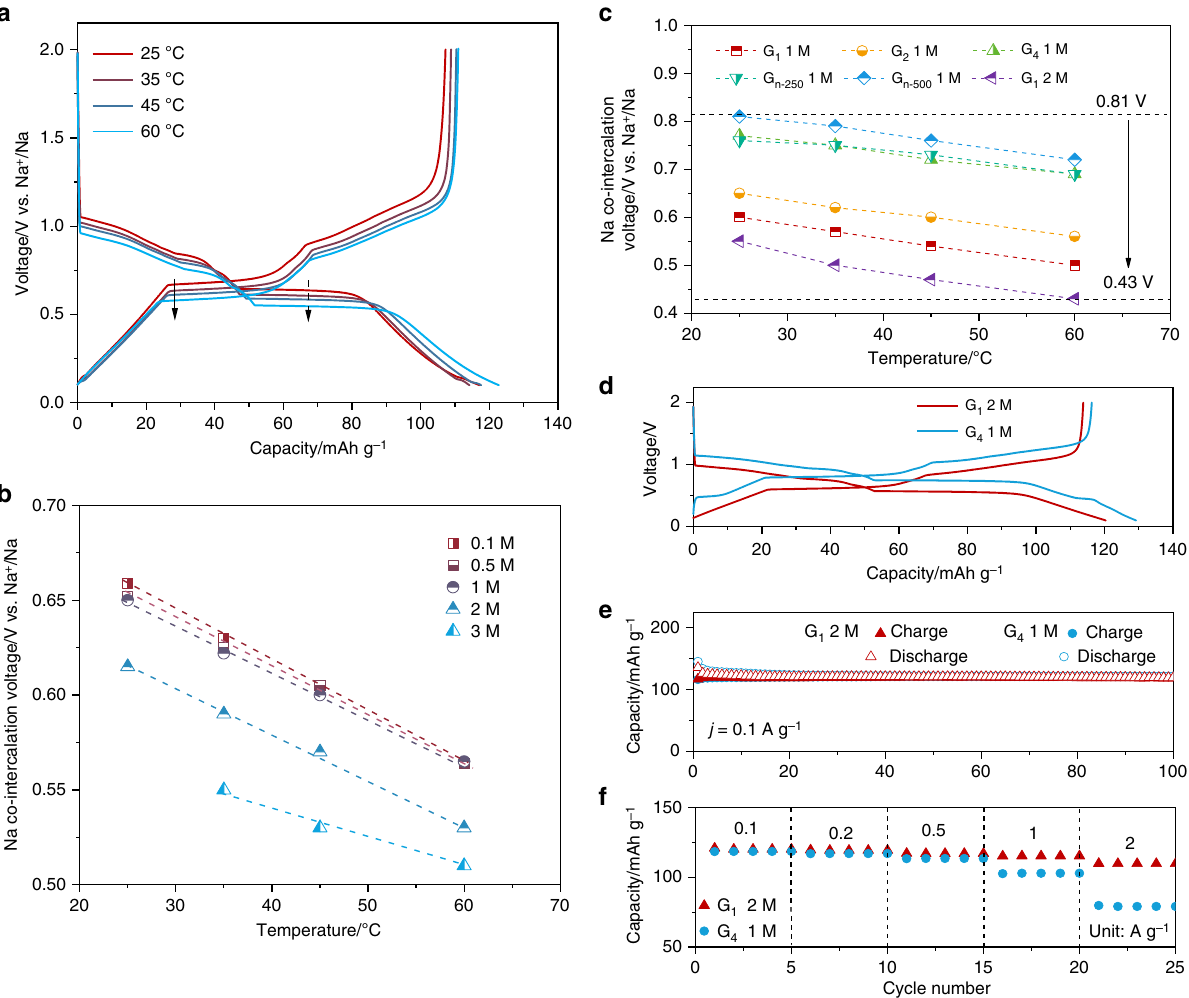
Fig. 3 Temperature dependency of co-intercalation voltage and optimal conditions for low co-intercalation voltage. a Galvanostatic discharge/charge pro fi les of graphite anodes in 1 M NaPF 6 G 2 electrolyte at different temperatures. b Na co-intercalation voltage in graphite anodes at different concentrations of G 2 -based electrolytes plotted as a function of operating temperature. c Summary of Na co-intercalation voltage at different temperatures in different electrolytes. d Discharge/charge voltage pro fi les. e Cyclic capacities and f rate capabilities of graphite anodes cycled in 1 M G 4 and 2 M G 1 - based